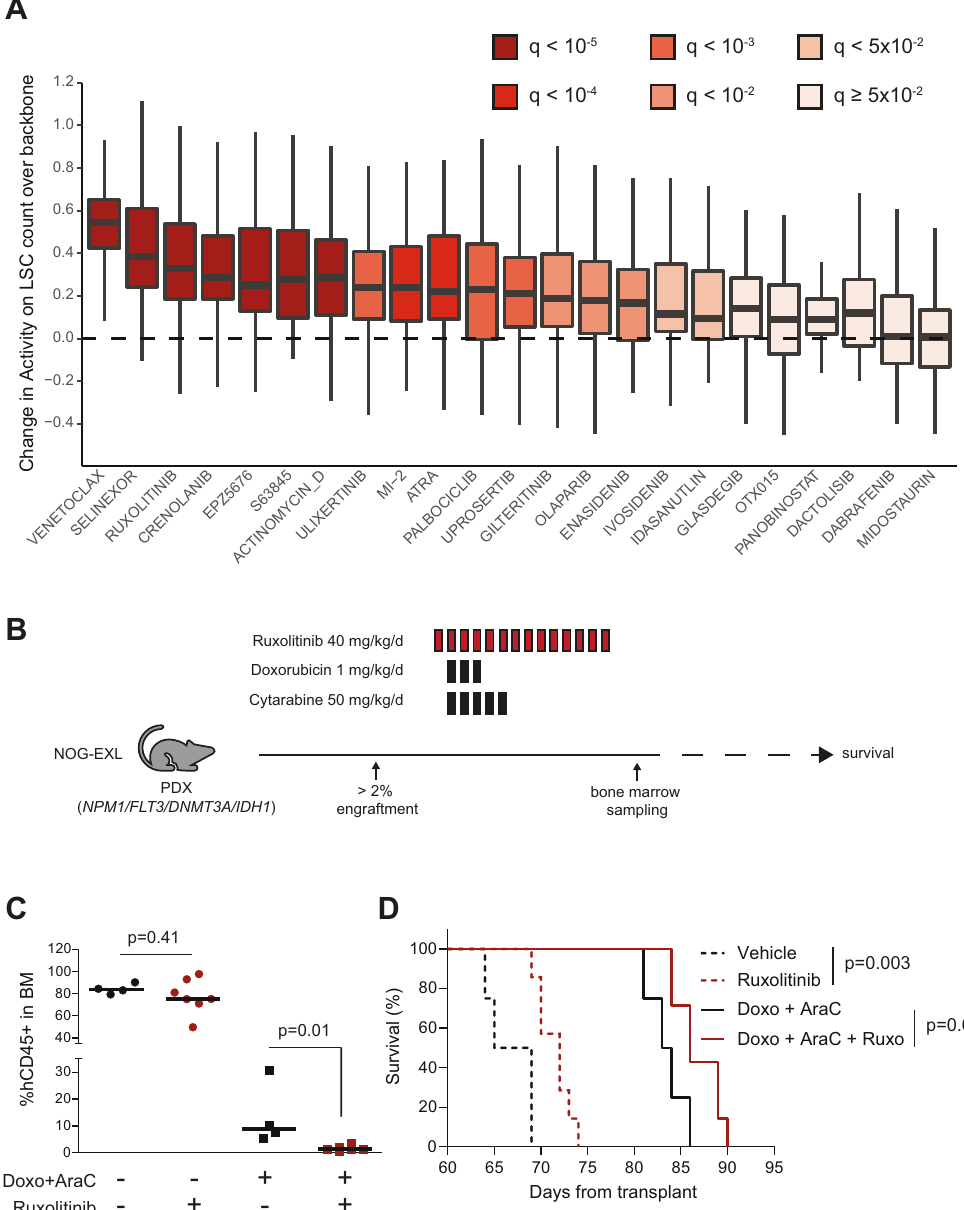
Fig. 6 Niche-like multiparametric drug screening platform identi fi es chemosensitization by ruxolitinib. A Boxplot of the difference between drug activity on the count of GPR56 + /Diff − LSCs for each of the 23 triplets tested in the DNR-AraC screen (Fig. 5) and that of DNR- AraC backbone. FDR q values from t tests. B Experimental plan of the in vivo assessment of vehicle ( n = 4), ruxolitinib ( n = 8, 40 mg/kg/d orally, d1 – 14), chemotherapy ( n = 4, doxorubicin 1 mg/kg/d IV d2-4 and cytarabine 50 mg/kg/d IP d2-6), or chemotherapy + ruxolitinib ( n = 8) treatment of a PDX model ( NPM1c , FLT3 ITD , DNMT3A R88H , and IDH1 R132H mutations) after engraftment into sub-lethally irradiated NOG-EXL recipient mice. C Proportion of hCD45 + leukemic cells in bone marrow aspirates performed at day 16 (hence 2 days after the last ruxolitinib or vehicle administration). P values from Mann – Whitney tests. D Overall survival of the four mice groups since the fi rst day of treatments. P values from log-rank